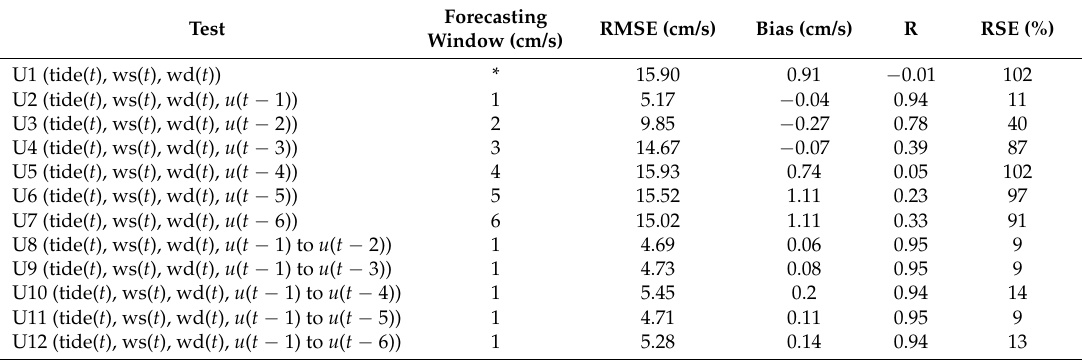
Table 4. Averaged statistics of u velocity component at ten points (testing dataset). Forecasting Test Window